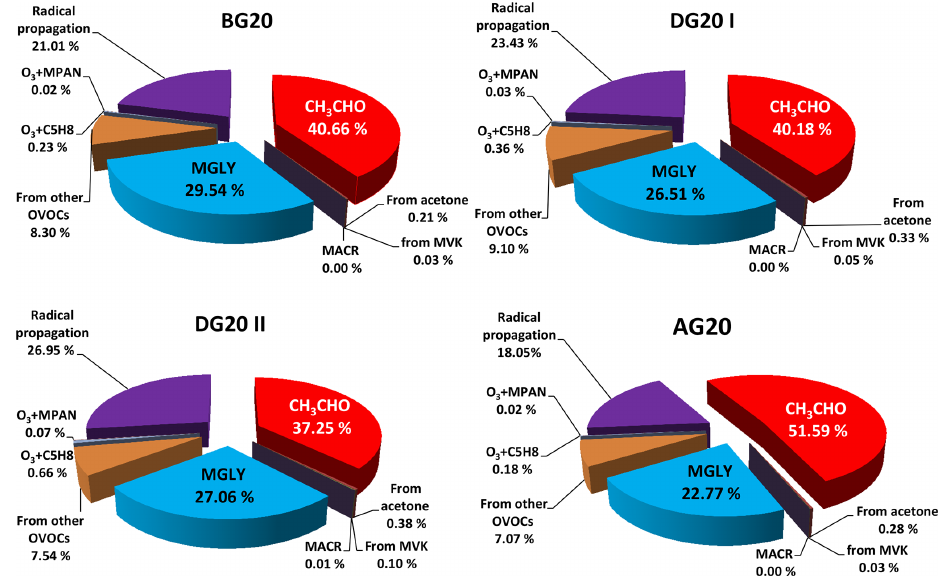
Figure 3. Contributions of individual pathways to PA radical formation during the episodes of BG20, DG20 I, DG20 II, and